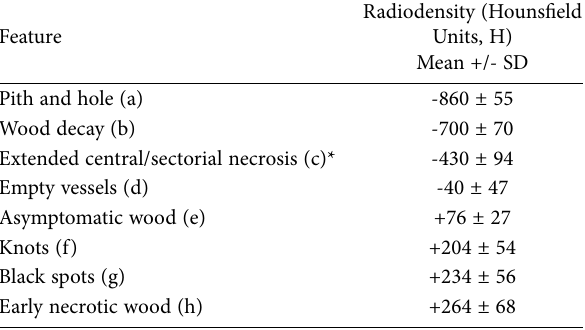
Table 1. Radiodensity values (H) obtained from computerized axial tomography for distinct parts of grapevine wood, either asympto- matic or with different wood defects. Lower case letters represent the features identified in Figures 1 and 4. Mean ± standard devia- tion (n = 40 wood sections, 4 grapevine trunks).